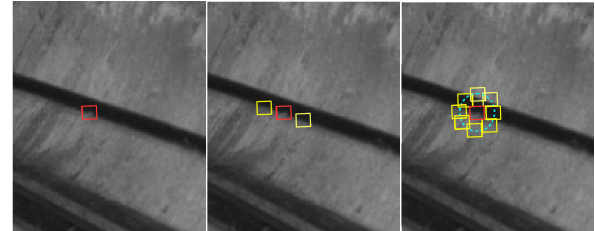
Figure 7. Non-repetitive filter. Left and middle: Risk of false match with linear pattern. Right: Verify the patch of one candidate (red) with patches around (yellow).